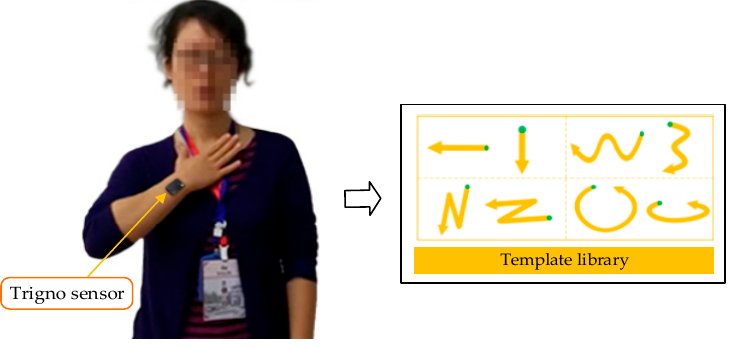
Figure 6. Establish template trajectory library.